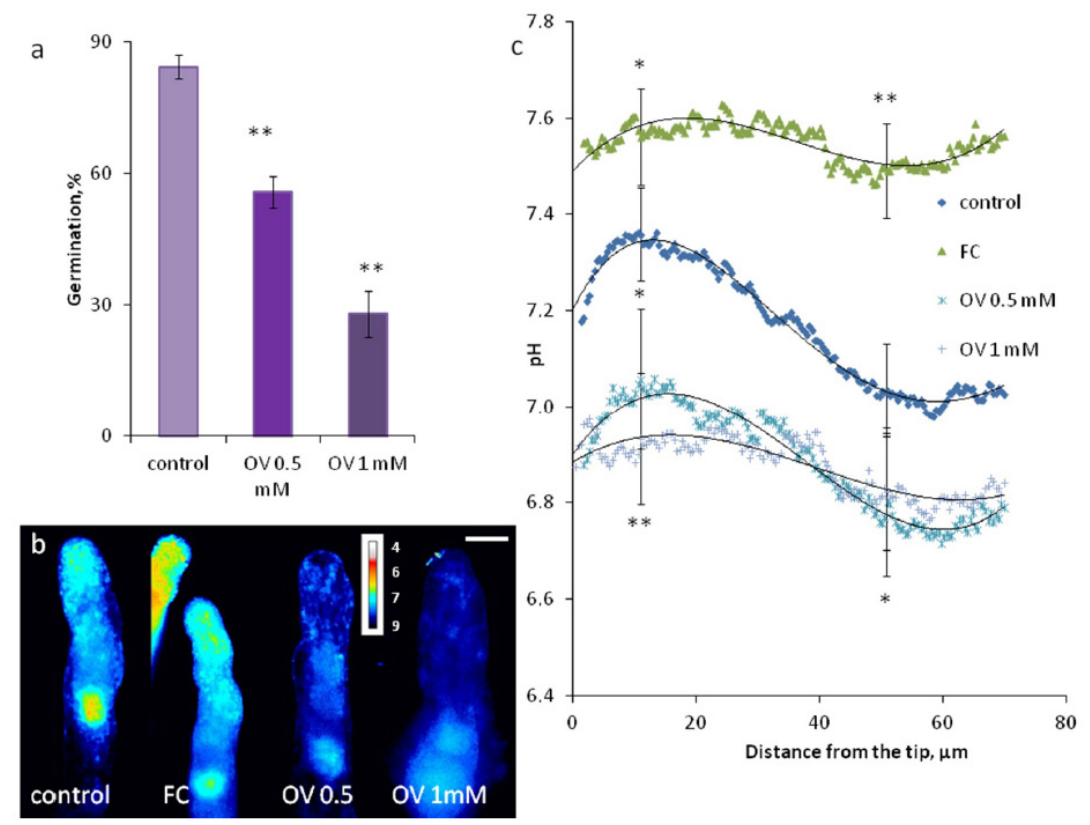
Figure 3. Intracellular pH in Picea pollen tubes. ( a ) Germination efficiency affected by inhibitor orthovanadate (OV); ( b ) pH distribution in typical pollen tubes treated by OV and H + -ATPase activator fusicoccin (FC); ( c ) pH distribution in pollen tubes treated with OV and FC, where each curve is an average from 21–53 pollen tubes. Statistics are shown for 2 points: 10 and 50 µm from the tip. ** p < 0.01; * p < 0.05. Bar: 20 µm.